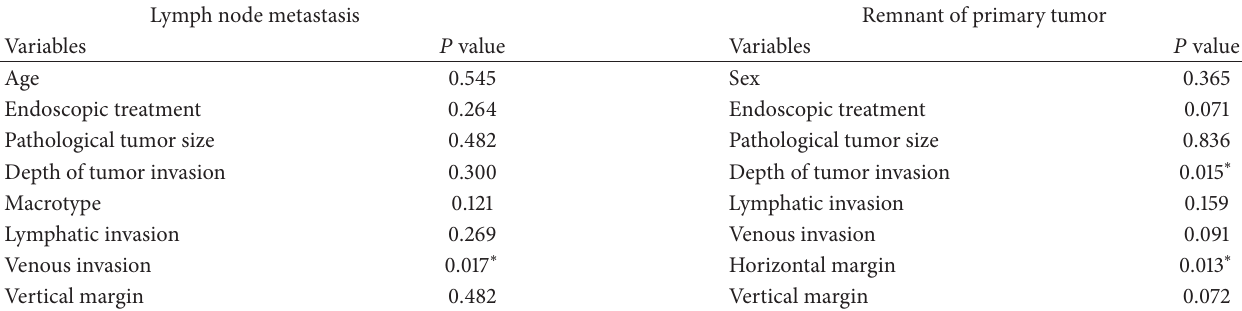
Table 3: Results of multivariate analyses showing relationships among clinicopathological characteristics of the